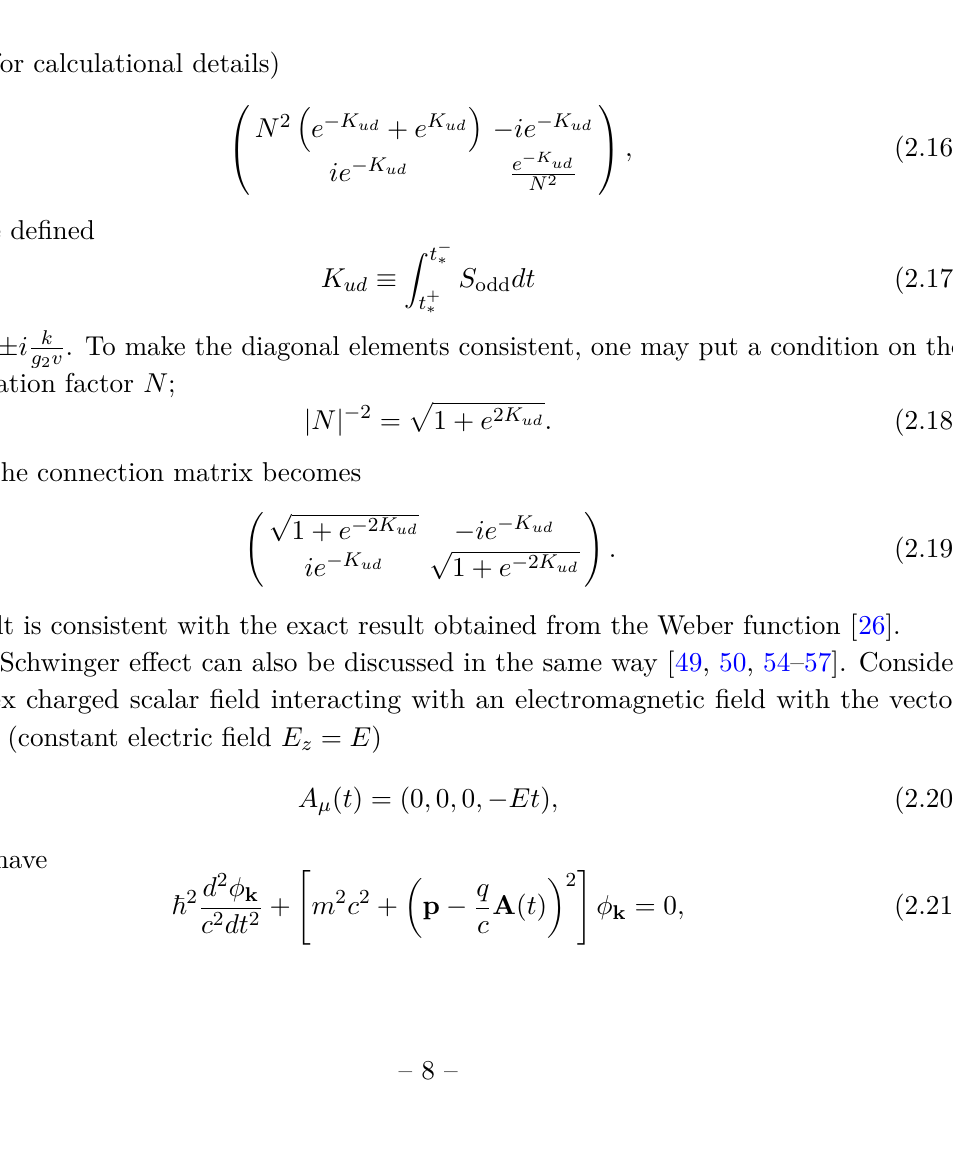
Figure 1 . The potential V ( t ) = − 1 − t 2 ( E = 0 ) is shown on the upper left panel, in which the horizontal axis is real t . Other panels are the Stokes lines for Im [ η ] = 0 (lower left), Im [ η ] > 0 (upper right) and Im [ η ] < 0 (lower right) shown on the complex t -plane. The Stokes lines have degenerated for Im [ η ] = 0 and there is a gap between Im [ η ] > 0 and Im [ η ] < 0 . The MTP structure has turning points at t = ± i